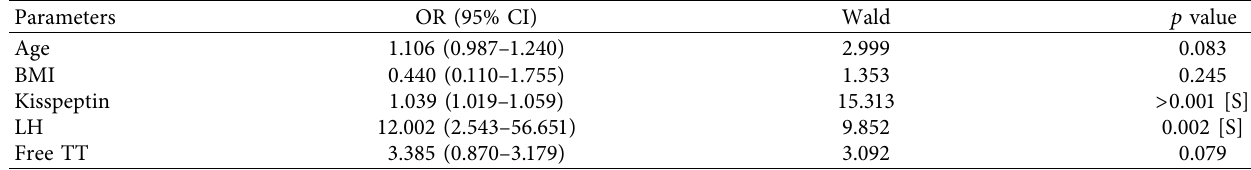
Figure 3: ROC analysis for kisspeptin levels between the PCOS and the control Table 4: Multiple regression analysis for the e factors that affect PCOS.